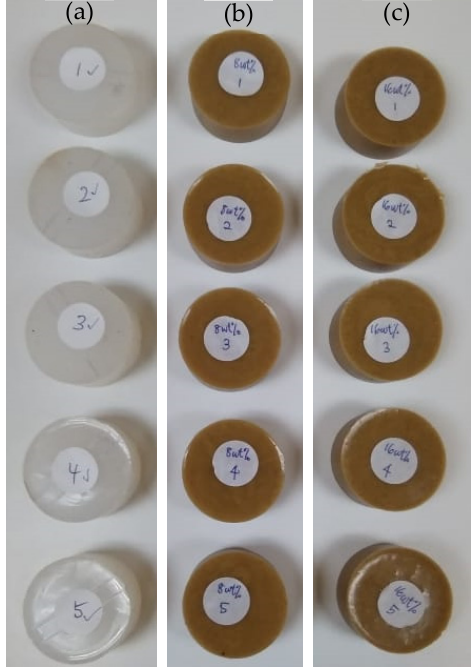
Figure 4. ( a ) 0 wt%, ( b ) 8 wt%, and ( c ) 16 wt% bamboo fibre–reinforced silicone rubber biocomposite specimens for compression test.